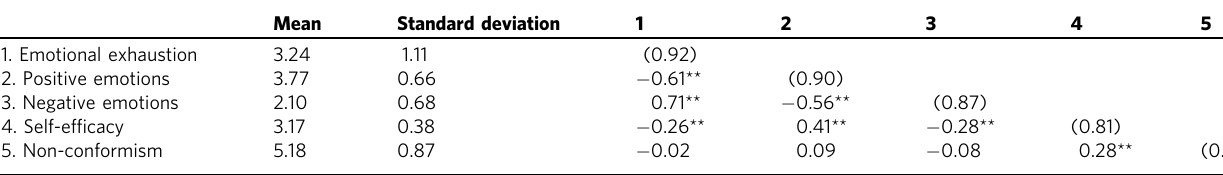
Table 1 Means, standard deviations and correlations among study variables.